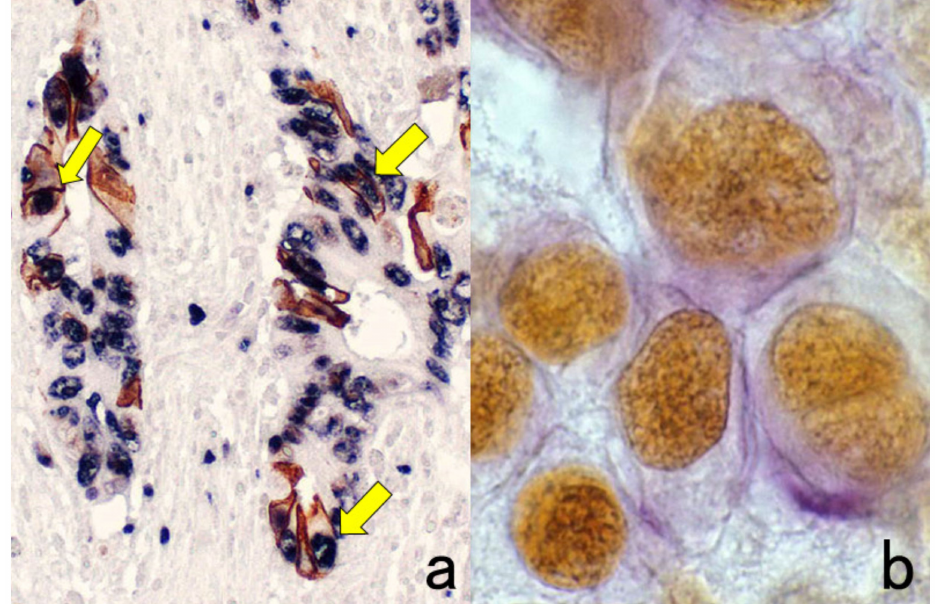
Figure 3. Chromogenic double immunostaining. ( a ): Ki-67 (nuclei of proliferative cells are blue) and cleaved cytokeratin 18 (cytoplasm of apoptotic columnar cells is brown) in FFPE colonic adenocarci- noma after neoadjuvant chemotherapy. In colon cancer, some proliferative cells are apoptotic, as the arrows indicate. Cleaved cytokeratin 18 functions as an excellent marker for apoptotic columnar cells. ( b ): HER2-positive plasma membranes in blue and p53-positive nuclei in brown in an ethanol-fixed aspiration cytology specimen of breast cancer. In this high-grade breast cancer, the atypical ductal cells overexpress both HER2 and